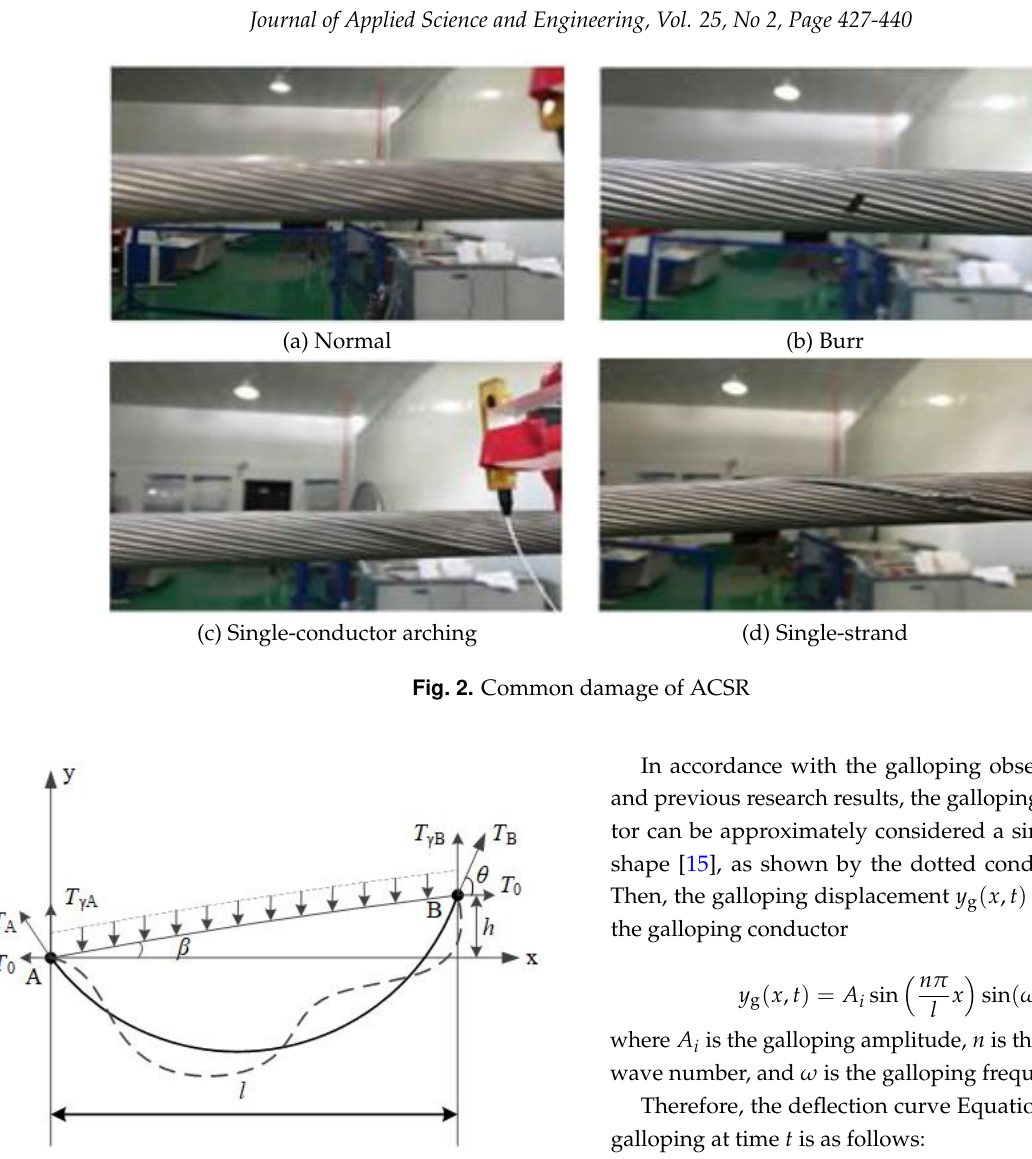
high-speed railway is shown in Fig.